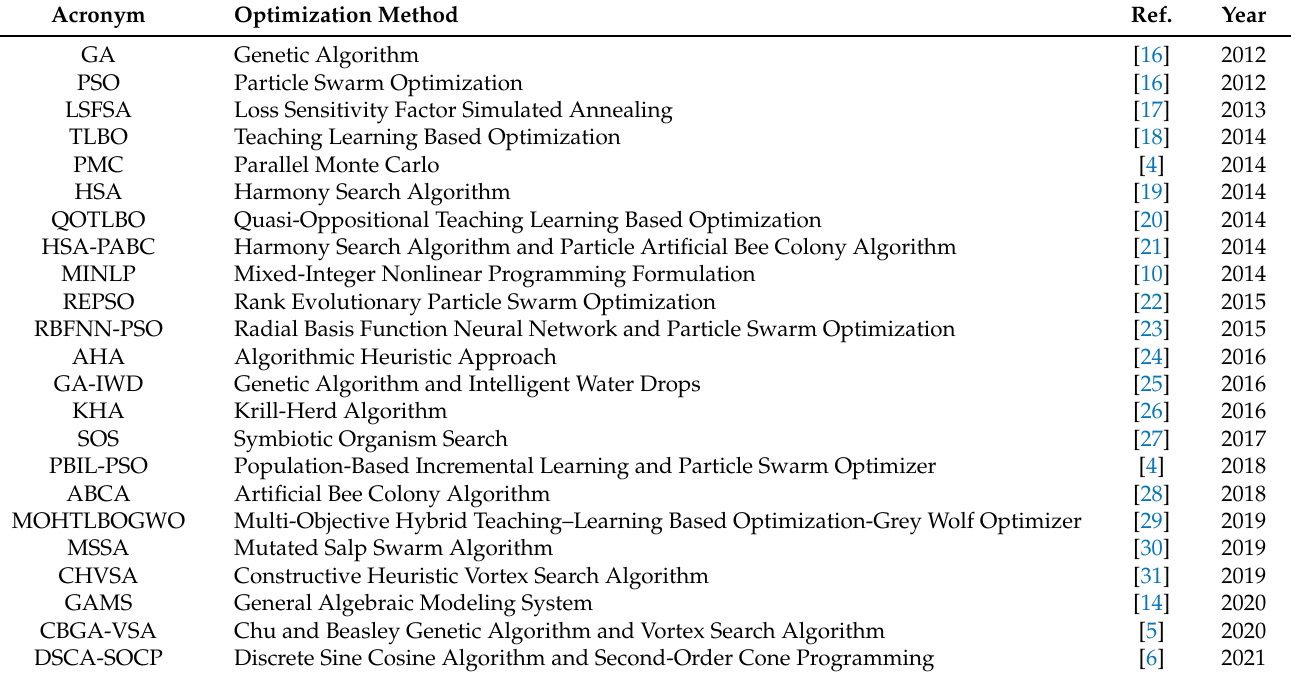
Table 1. Methods recently used to reduce energy losses in distribution